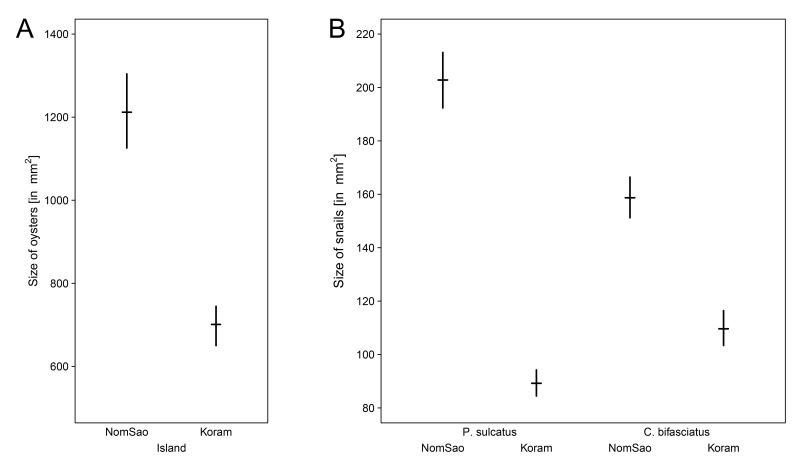
Prey size on Koram and NomSao Islands.(A) Average size of oysters (with bootstrapped 95% confidence intervals) found on Koram and NomSao Islands. (B) Average snail size (volume) (with bootstrapped 95% confidence intervals) found on Koram and NomSao Islands.10.7554/eLife.23647.011Figure 5—source data 1.Oyster size.The size of rock oysters measured in width and length on Koram and NomSao Islands, Thailand.10.7554/eLife.23647.012Figure 5—source data 2.Snail size.The size (length) of three marine snails (N = 100 each) on Koram and NomSao Islands, Thailand.